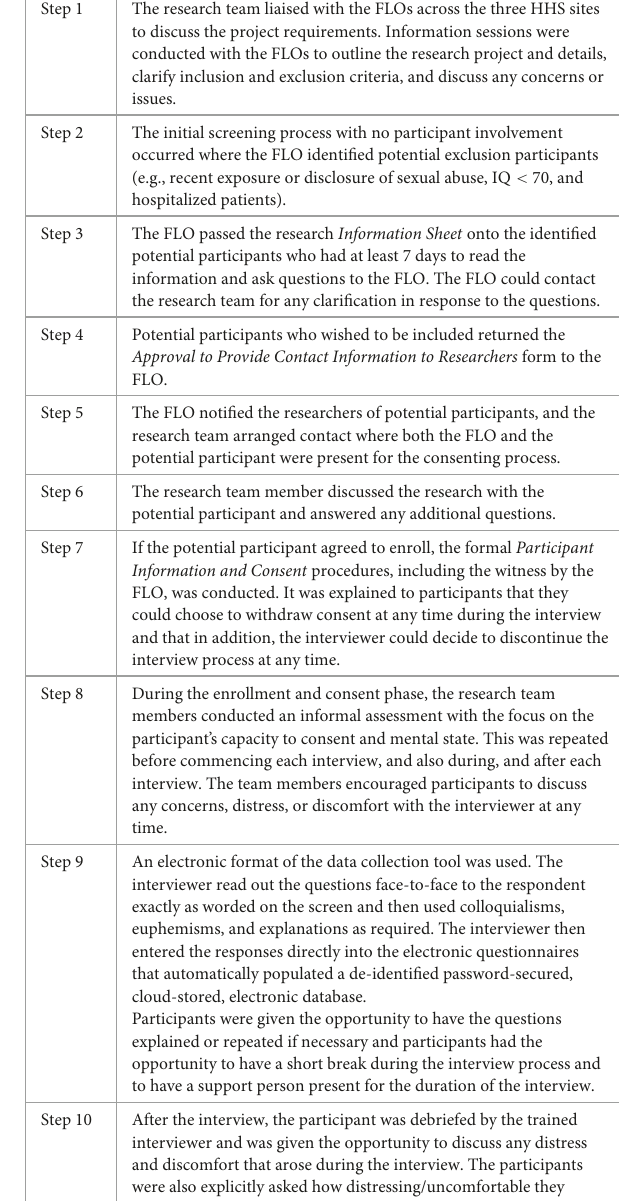
TABLE 3 Identification, enrollment, and informed consent